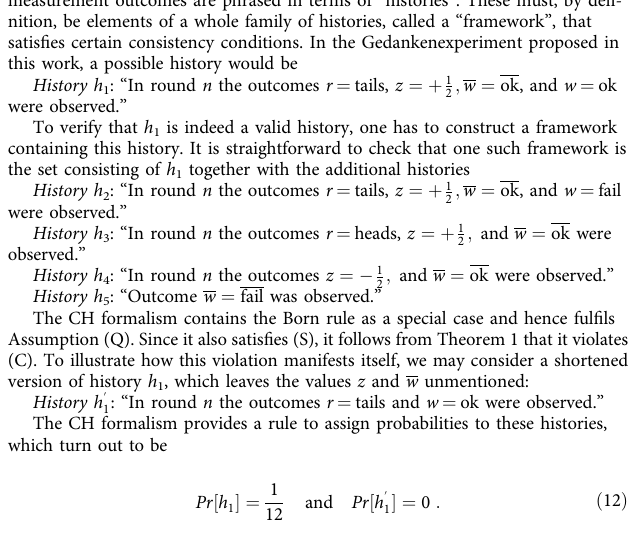
Table 4 Interpretations of quantum